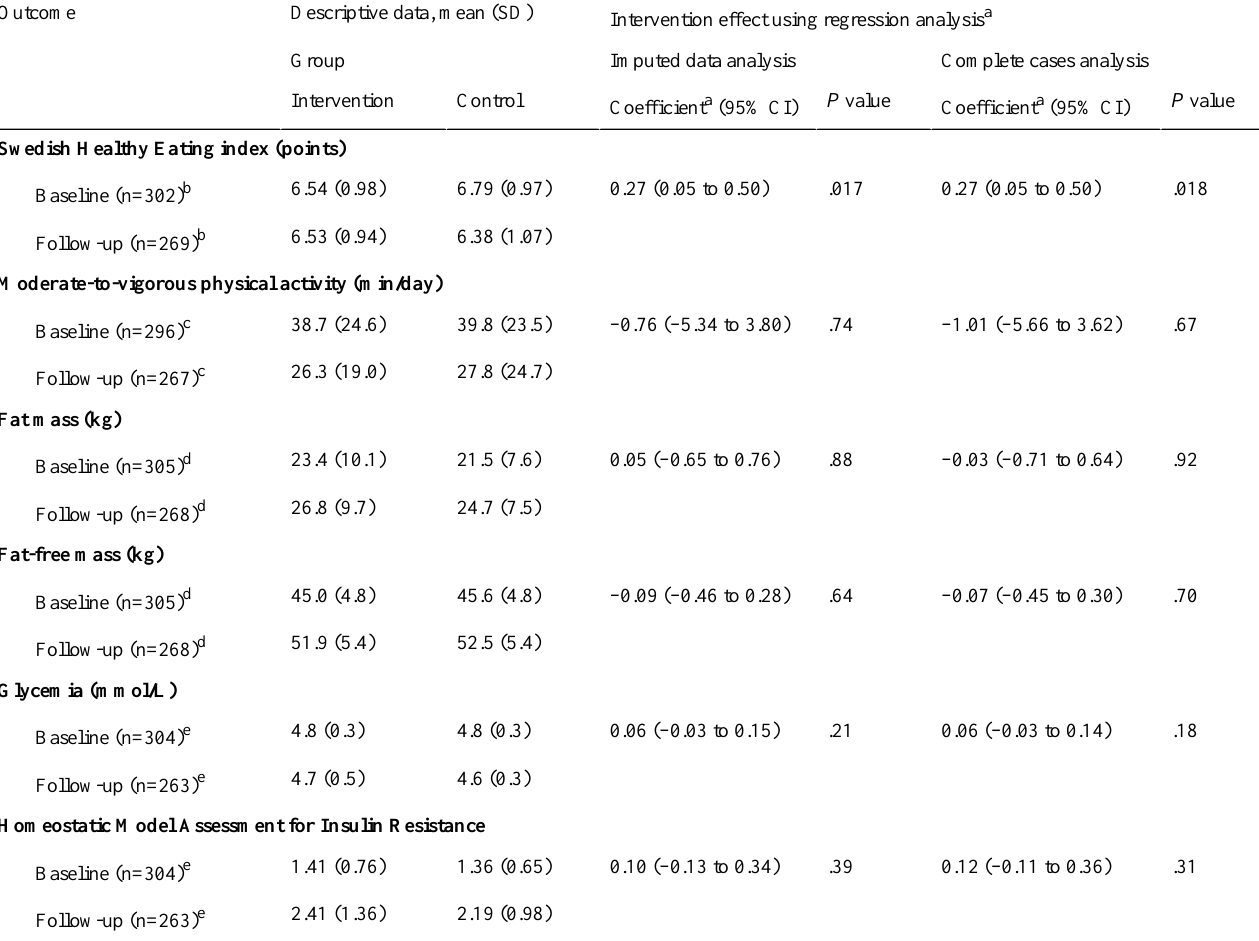
Table 5. Intervention effect on the secondary outcomes.